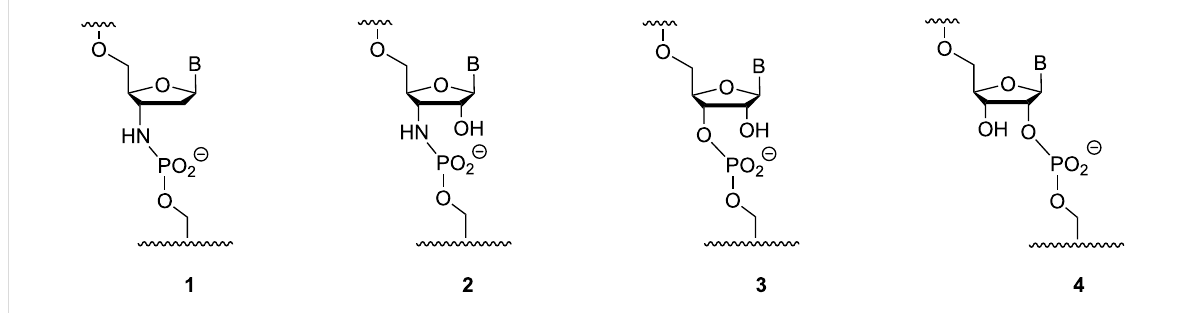
Figure 3: Structures of backbone linkages produced in enzyme-free primer extension reactions: the phosphoramidate of a 3'-amino-2',3'-dideoxynu- cleoside ( 1 ), the phosphoramidate of a 3'-amino-3'-deoxynucleoside ( 2 ), the 3',5'-phosphodiester of a natural ribonucleoside ( 3 ), and the isomeric